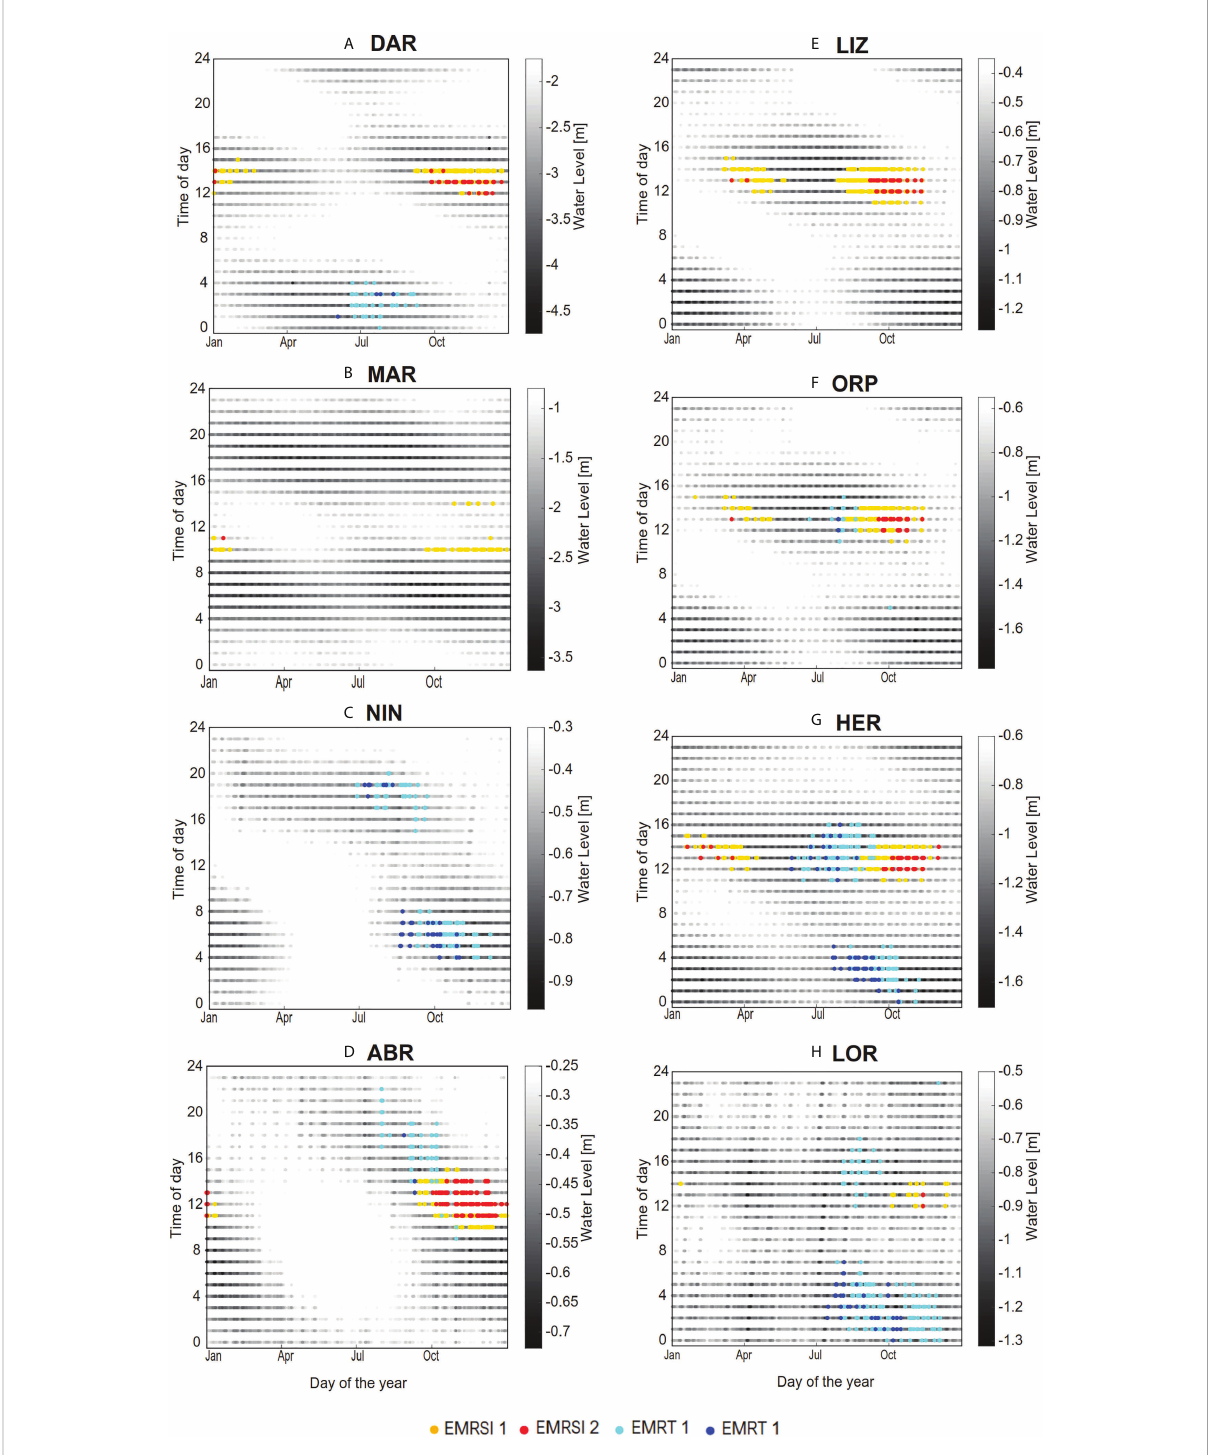
FIGURE 6 Seasonal and daily timing of water levels (m) for sites (A) Darwin (DAR), (B) Maret Island (MAR), (C) Ningaloo Reef (NIN), (D) Abrolhos Islands (ABR), (E) Lizard Island (LIZ), (F) Orpheus Island (ORP), (G) Heron Island (HER) and (H) Lord Howe Island (LOR) based on hourly data for each calendar day over the years 1992 – 2016, highlighting emersion mortality risk due to high solar irradiance and low atmospheric temperature. Coincidence of emersion with values above Ɵ SI 1 are indicated in yellow (EMRSI 1) and Ɵ SI 2 in red (EMRSI 2), and coincidence of emersion with temperature values less than Ɵ T w 1 (EMRT w 1) are indicated in light blue and Ɵ T w 2 (EMRT w 2) in darker